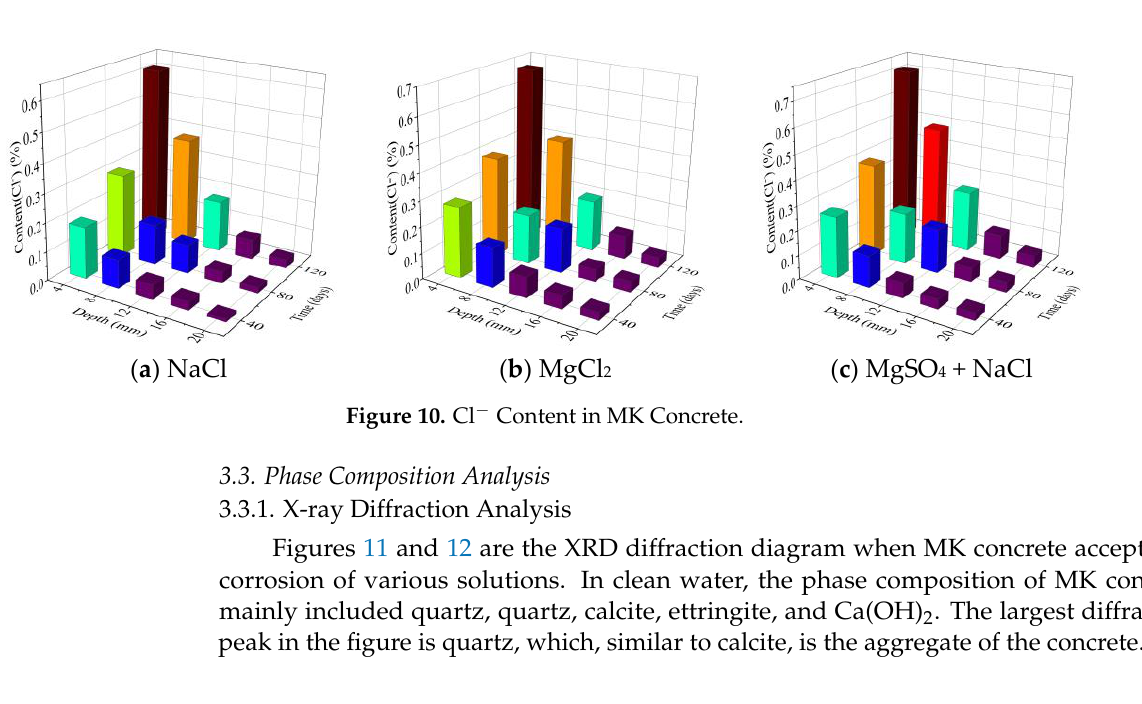
Figure 9. Mg 2+ Content in MK Concrete.